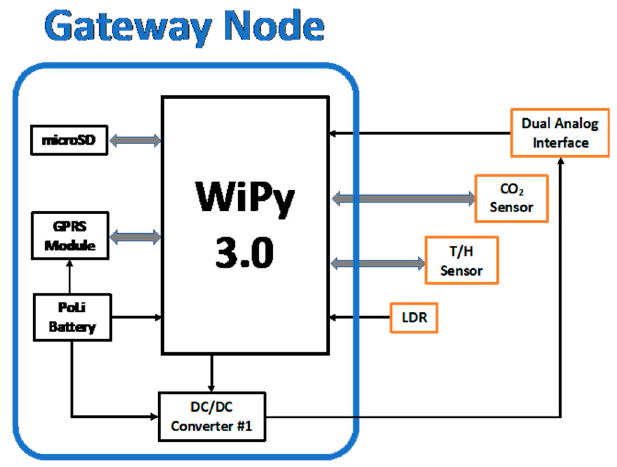
Figure 5. Gateway node architecture diagram.